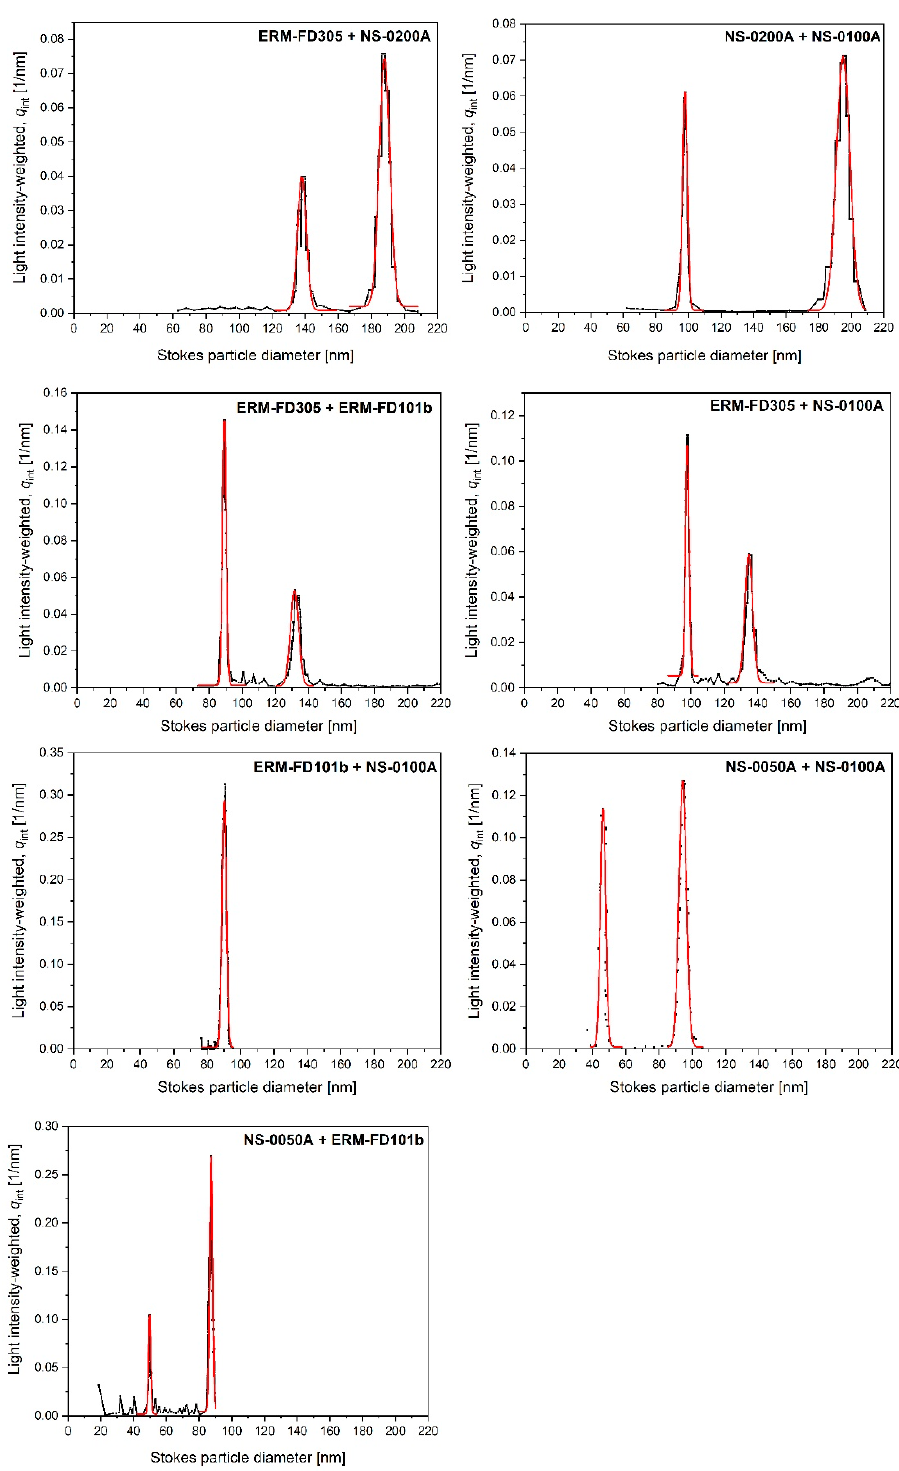
Figure 1. Representative examples of light intensity-weighted PSDs of bimodal colloidal silica mixtures obtained by cuvette-CLS, red curves are Gaussian fits.